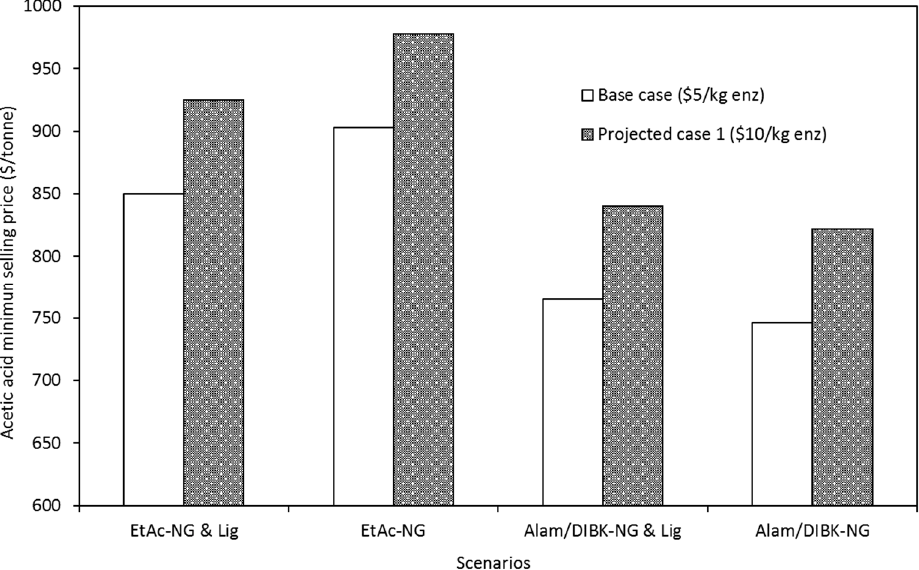
Figure 4. Effect of the enzyme (enz) cost on minimum selling price of acetic acid for a projected case (enz = 10 USD/kg) for a biorefinery with a capacity of 120, 650 tons of acetic acid per year.